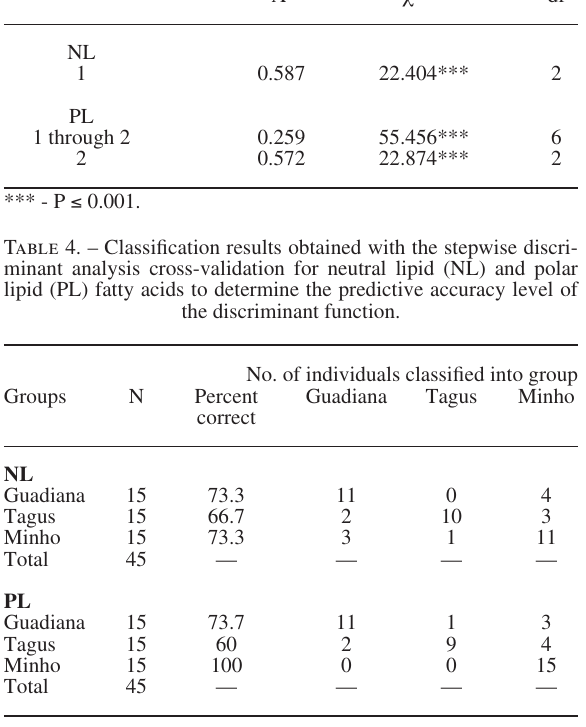
Table 3. – results of Wilk’s lambda test to verify: (1) the hypothesis that the means (centroids) of function are equal in the three groups when their neutral lipids (nl) fatty acids were separately compared by stepwise mda; (2) the hypothesis that the means (centroids) of both functions are equal in the three groups when their polar lipid (Pl) fatty acids were separately compared by stepwise mda. the first function separates one group from the other two, and the second separates the remaining two groups test of function(s)